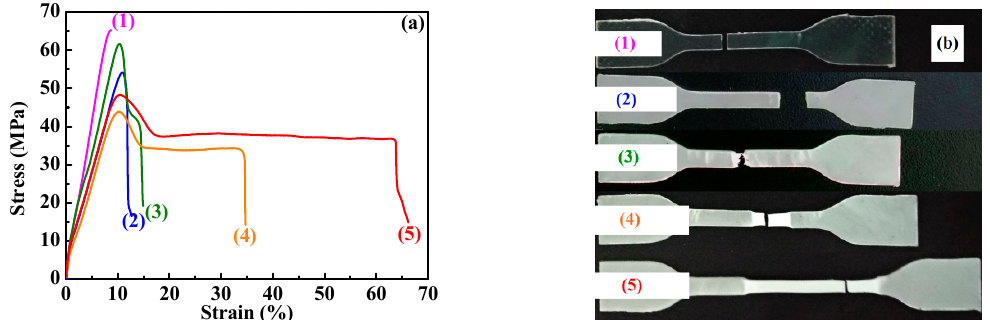
Figure 6. ( a ) Stress ‒ strain behaviors and ( b ) images of typical fractured tensile specimens for (1) (neat) PLA, blends of PLA and SBS triblock copolymer (95/5 w/w) (2) uncompatibilized and (3) compatibilized with 1.0 wt % of S-MA, and blends of PLA and SBS (90/10 w/w) (4) uncompatibilized and (5) compatibilized with 1.0 wt % of S-MA.